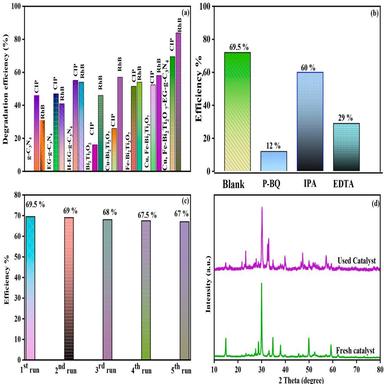
(a) The degradation efficiencies of CIP and RhB graph by the prepared materials, (b) trapping results for Cu, Fe-Bi2Ti2O7/ EG-g-C3N4, (c) recycling for Cu, Fe-Bi2Ti2O7/ EG-g-C3N4 catalyst, and (d) XRD for fresh and used Cu, Fe-Bi2Ti2O7/ EG-g-C3N4 catalyst.